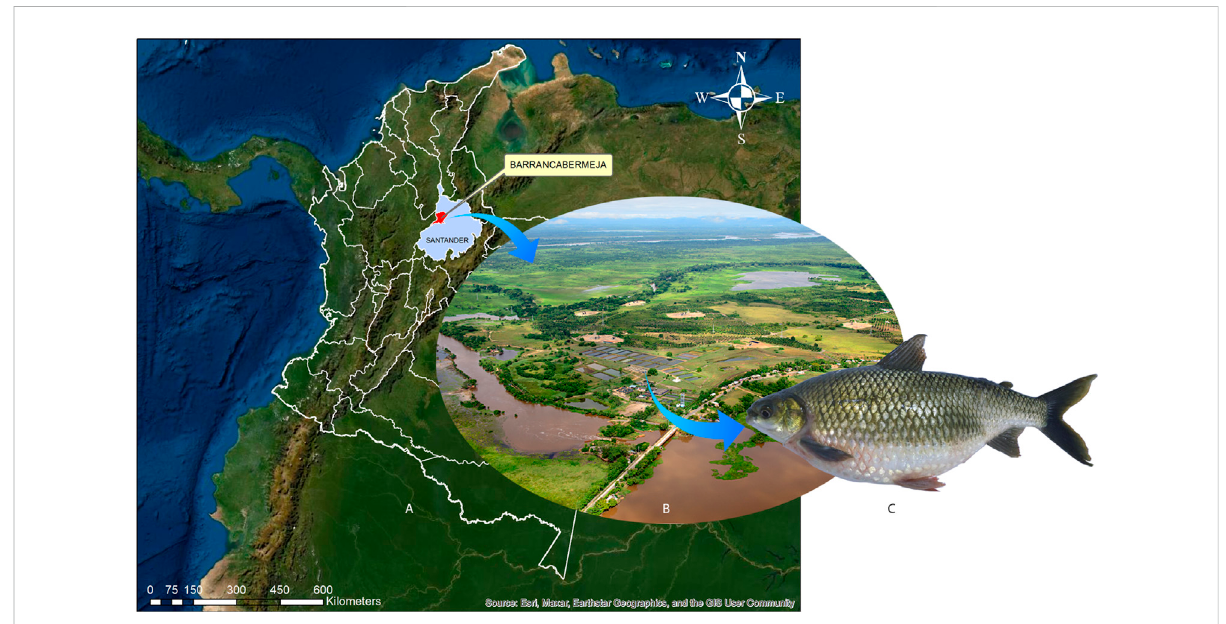
FIGURE 1 Prochilodus magdalenae specimen from which samples were collected and location